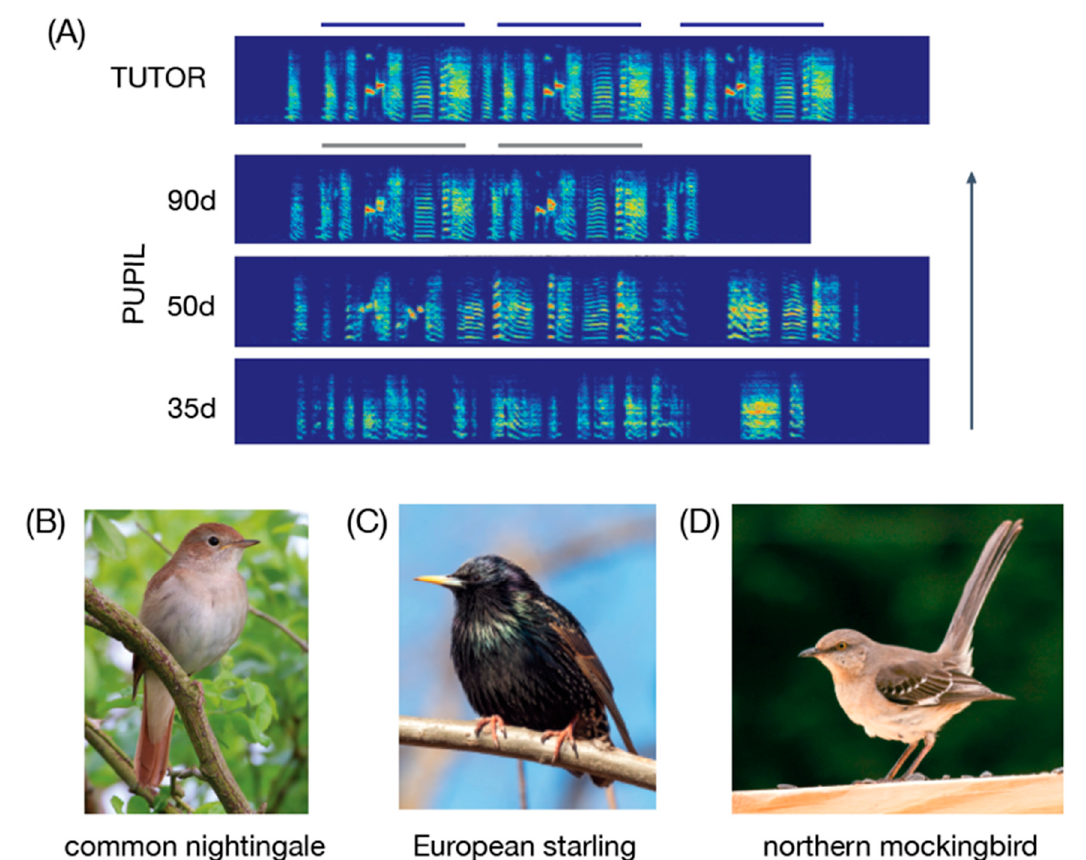
Figure 2. Song development and images of songbirds commonly studied with regard to late song (S2) learning. ( A ) As juvenile (<90 d of age) zebra finches mature, their songs become increasingly similar to those of their tutor. In other words, as juveniles engage in a protracted period of vocal practice, their songs become more similar to their tutor’s song. In this example, the 35d-old “pupil” (in this case, the offspring of the “tutor”) produces an acoustically variable sequence of noisy syllables that bears little resemblance to the tutor’s song. By the time he is 50d-old, the syllables have more defined harmonic structure and seem to show some acoustic similarity to the tutor’s song. By the time the bird is 90d-old, he produces a song with stereotyped sequences of syllables with distinct acoustic structure and that resembles the song of the tutor. ( B – D ) Images of three songbird species that have been studied with regard to late song learning; from Wikimedia Commons https: //commons.wikimedia.org/ (accessed on 13 December